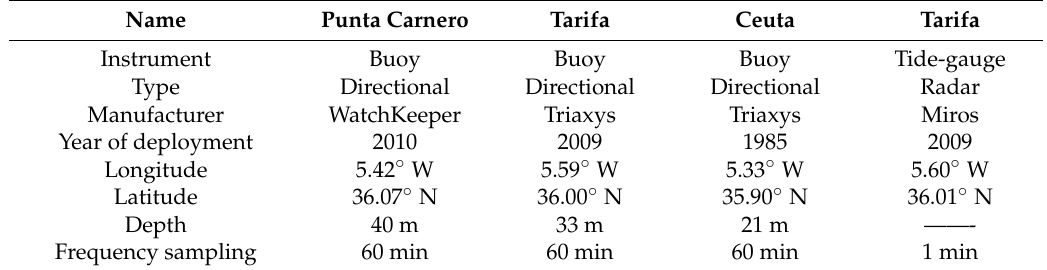
Table 1. Description of in situ instruments operated by Puertos del Estado in the Strait of Gibraltar.